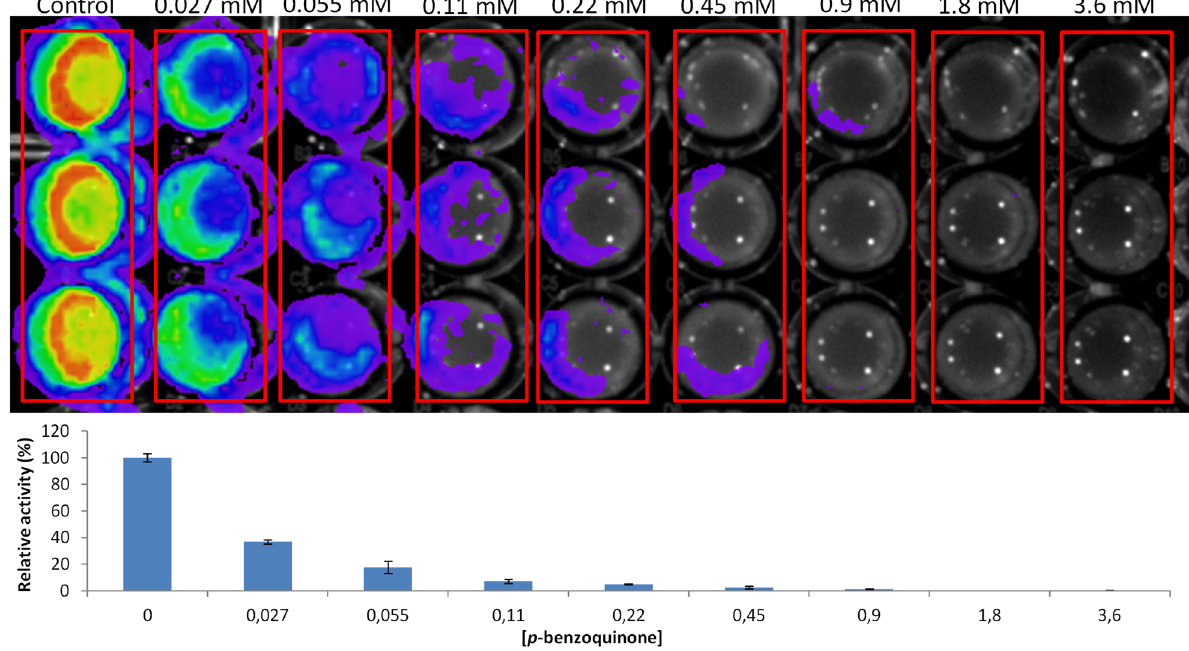
Figure 5. Toxic effect of p- benzoquinone at different concentrations on bacterial cell viability, analyzed by bioluminescence. The bars graph shows the bioluminescent activity at different p -benzoquinone